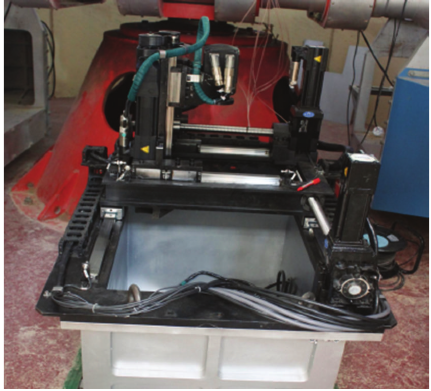
Figure 6: Centrifuge actuator.